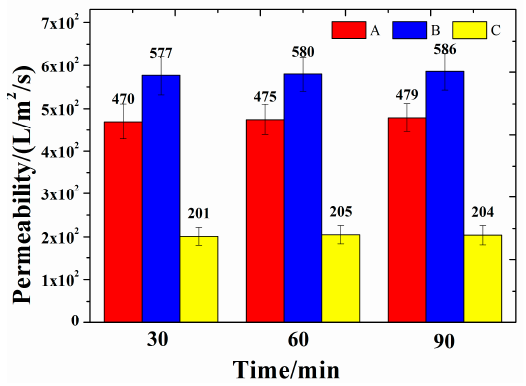
Figure 9. Air permeability of samples: (A) the temperature- and pH-sensitivity mulberry silk fabric modified with PNIPAAm/chitosan/PEO nanofibers; (B) silk fabric coated with PNIPAAm/chitosan/PEO solution; (C) mulberry Silk fabric. Data are presented as mean ± standard deviation.